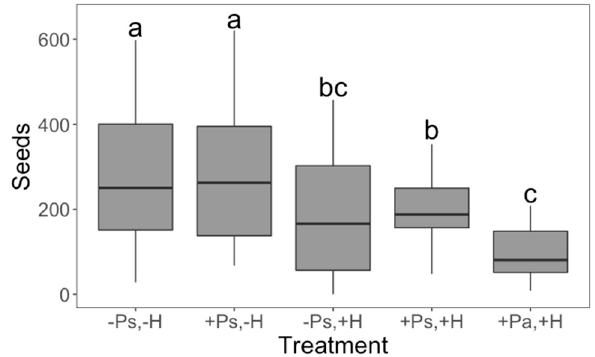
Figure 3. Effect of both priming (P) and herbivory (H) on seed production. Boxplots representing the median, minimum and maximum values are shown. Plants that experienced 50% of damage produced fewer seeds relative to undamaged plants. However, when primed with an allopatric insect, the negative effect of damage was higher. Plus (+) and minus ( − ) signs denote the presence/absence of the treatment; Ps and Pa denote priming being performed by a sympatric or allopatric insect, respectively. Different letters denote significant differences following a Tukey–Kramer test ( p < 0.05). There were 24 replicates (plants) per treatment ( n = 120).